Question: Judging by this figure, is the value going up or going down?
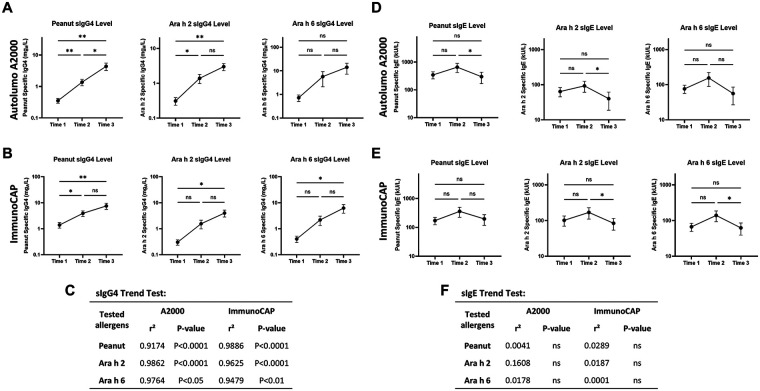
Answer: increasing